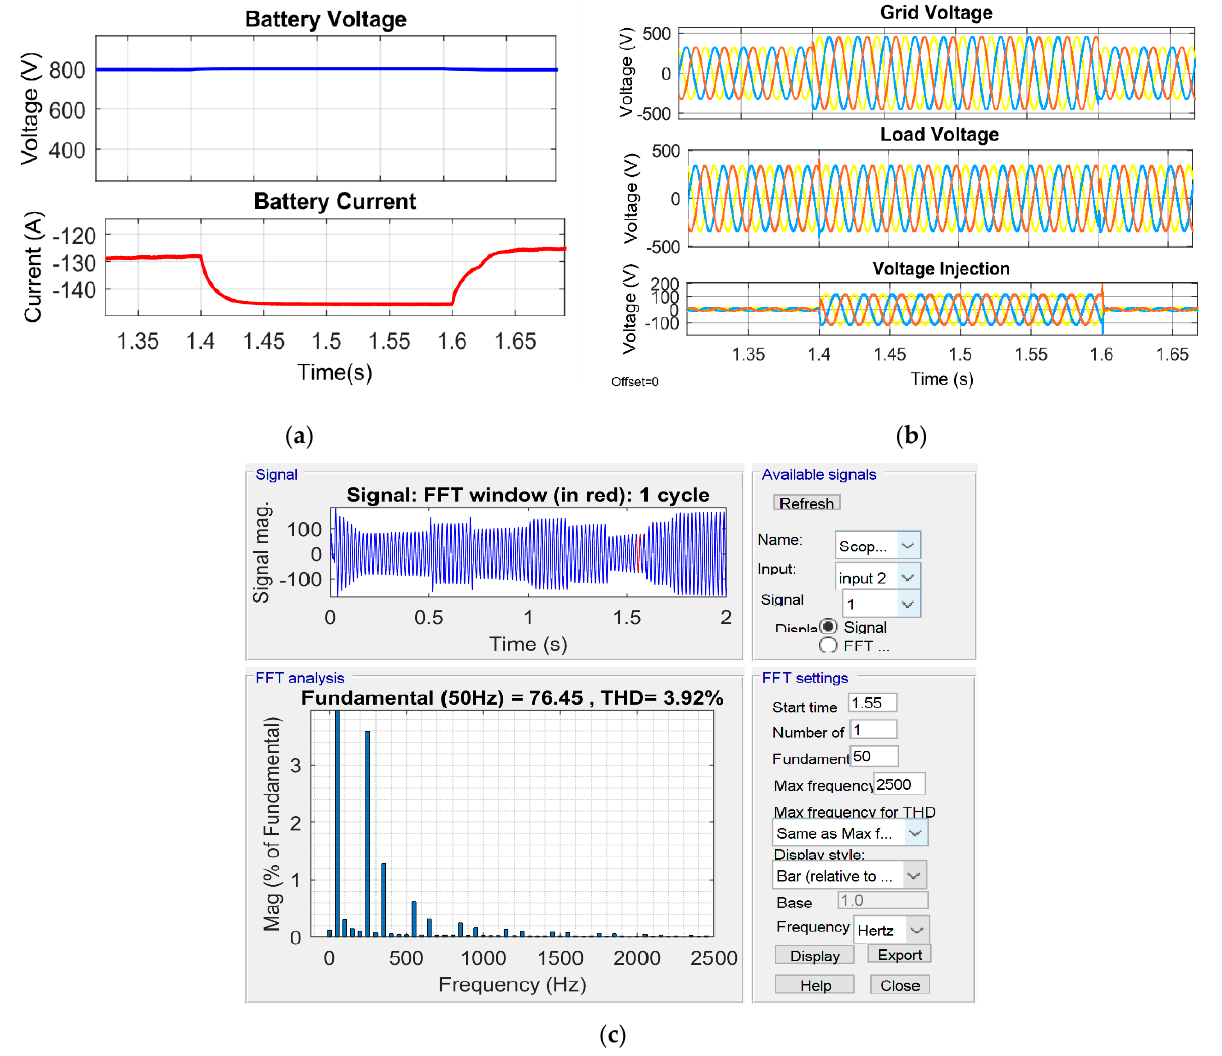
Figure 9. Response of the system parameters under voltage swell conditions. ( a ) Battery voltage and current under voltage sag condition ( b ) Grid voltage, Load voltage and voltage injection during voltage swell condition ( c ) THD during voltage swell condition.